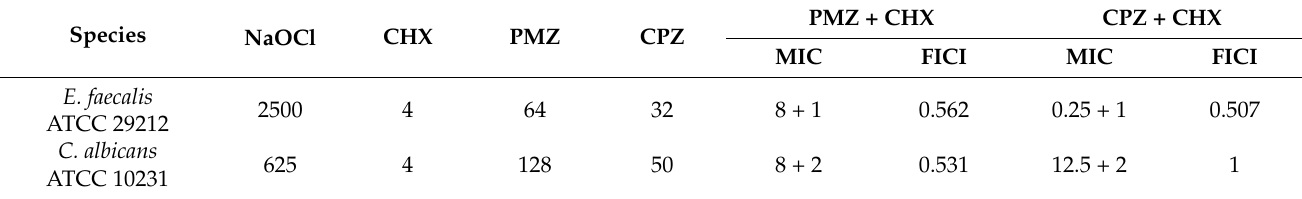
Table 1. Minimum inhibitory concentration (MIC) of NaOCl, CHX, PMZ and CPZ alone and in combination against planktonic E. faecalis and C. albicans . The results are expressed in µ g/mL.